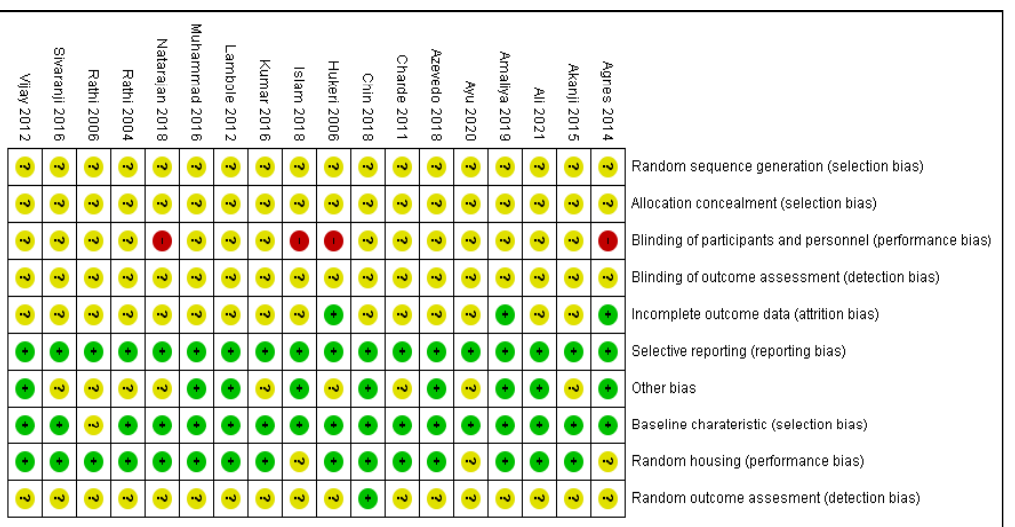
Figure 2. Risk of bias summary of included studies.